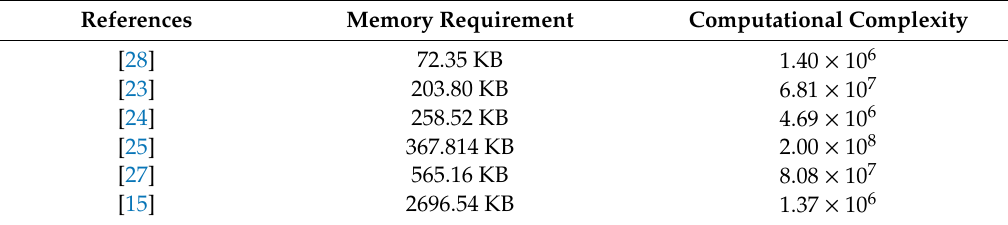
Table 1. Comparison of computational resource requirements of the main available